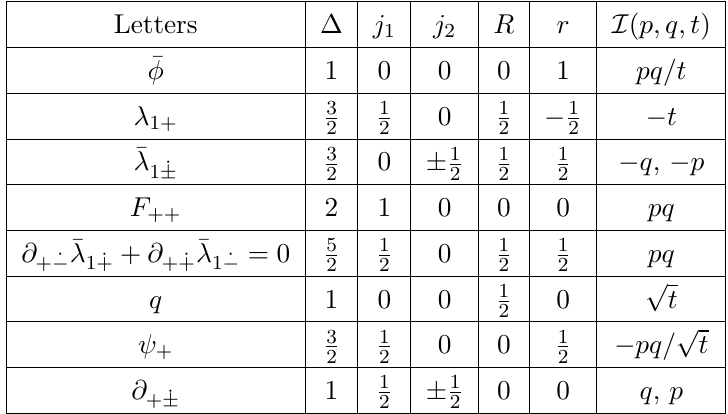
Table 8. Contributions to the index from \single letters". We denote by ( (cid:30); (cid:22) (cid:30); (cid:21) I;(cid:11) ; (cid:22) (cid:21) I _ (cid:11) ; F (cid:11)(cid:12) ; (cid:22) F the components of the adjoint N = 2 vector multiplet, by ( q; (cid:22) q; (cid:11) ; (cid:22) _ (cid:11) ) the components of the N = 1 chiral multiplet, and by @ (cid:11) _ (cid:11) the spacetime